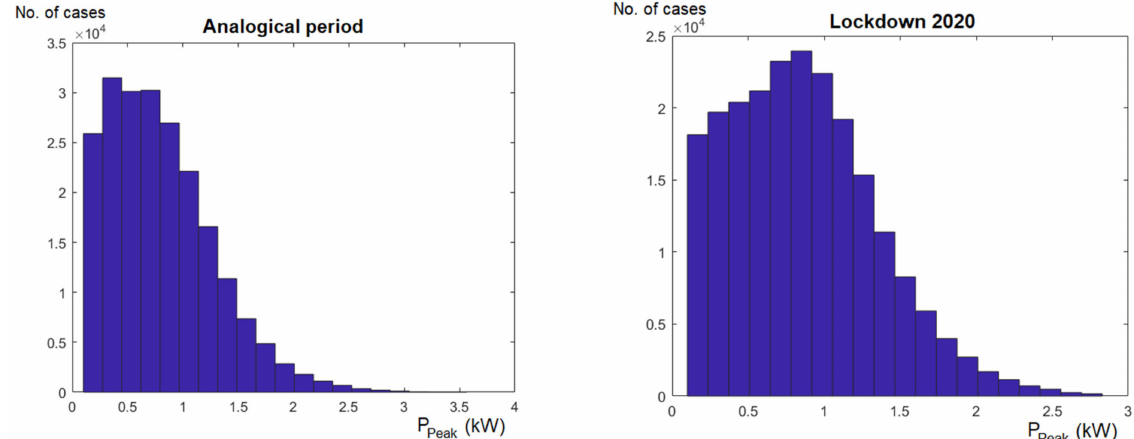
Figure 5. Histograms of the peak loads with active power during the lockdown and the analogous period in 2018.